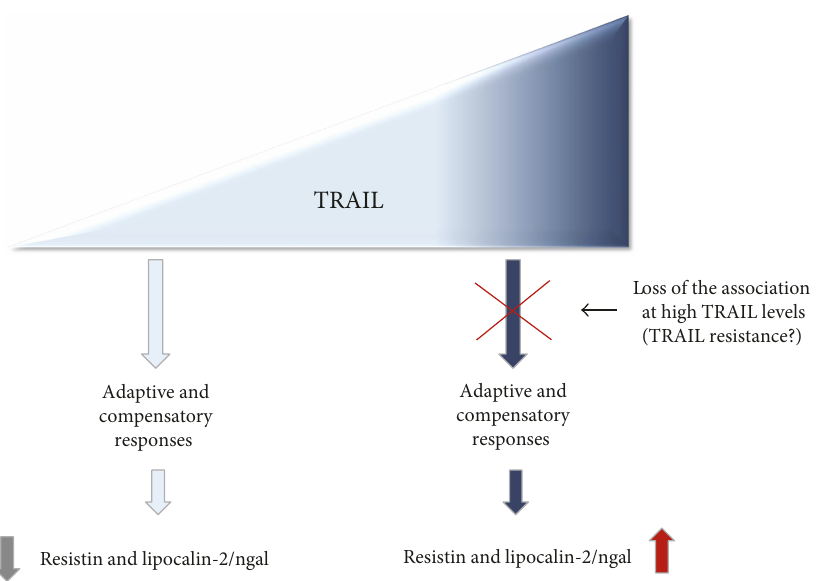
Figure 3: Schematic representation of the link between TRAIL and resistin/lipocalin-2 (ngal) in the context of obesity-induced metabolic alterations. The picture summarize the hypothesized axis between TRAIL and resistin and lipocalin-2/ngal leading to di ff erent outcomes according to TRAIL